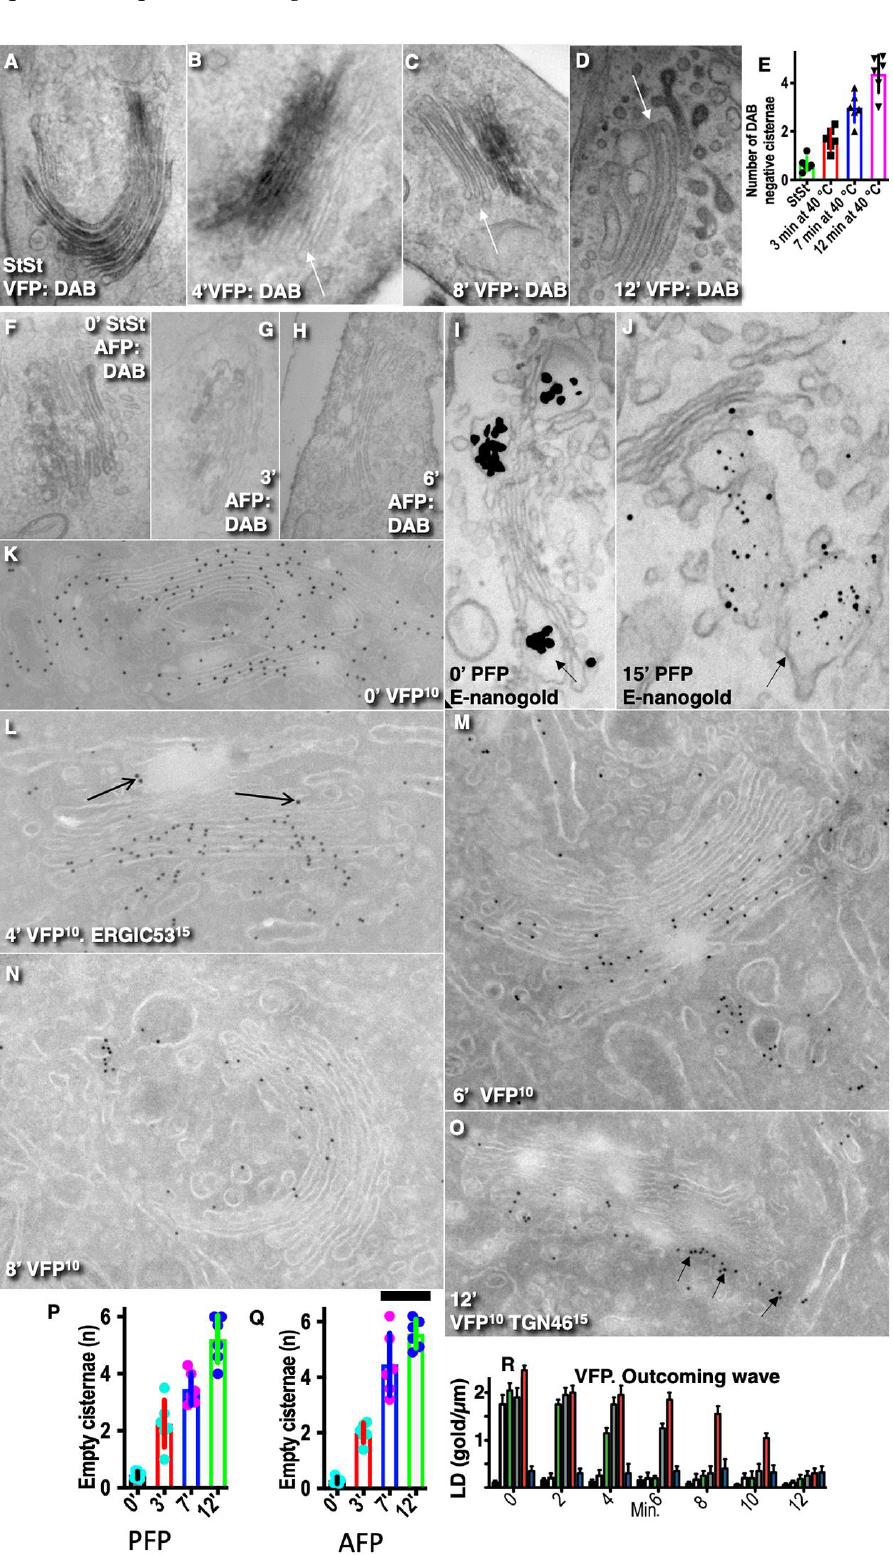
Figure 5. There is no equilibration of cargos across Golgi cisternae during the outgoing transport wave. ( A – D ; quantified in [ E ]) HeLa cells transfected with VFP were incubated at 40 °C for 3 h. Next, cells were placed at 32 ° for 30 min, returned at 40 ° (transport block), and examined after 4, 6, 8, and